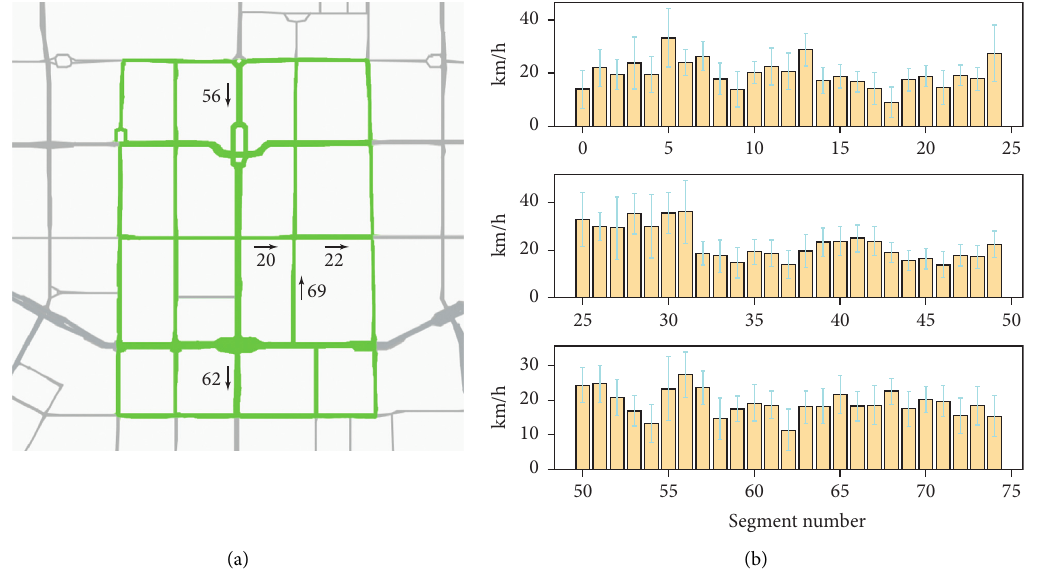
Figure 2: Study area and speed characteristics of each